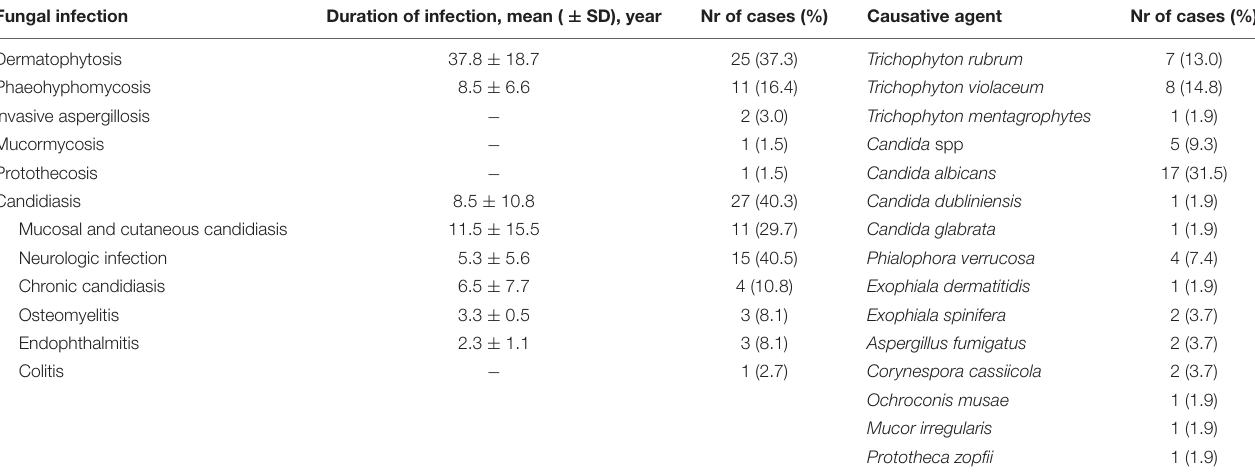
TABLE 1A | Prevalence of fungal infections, duration of infections and causative pathogens in patients with CARD9 deficiency. Fungal infection Duration of infection, mean ( ± SD), year